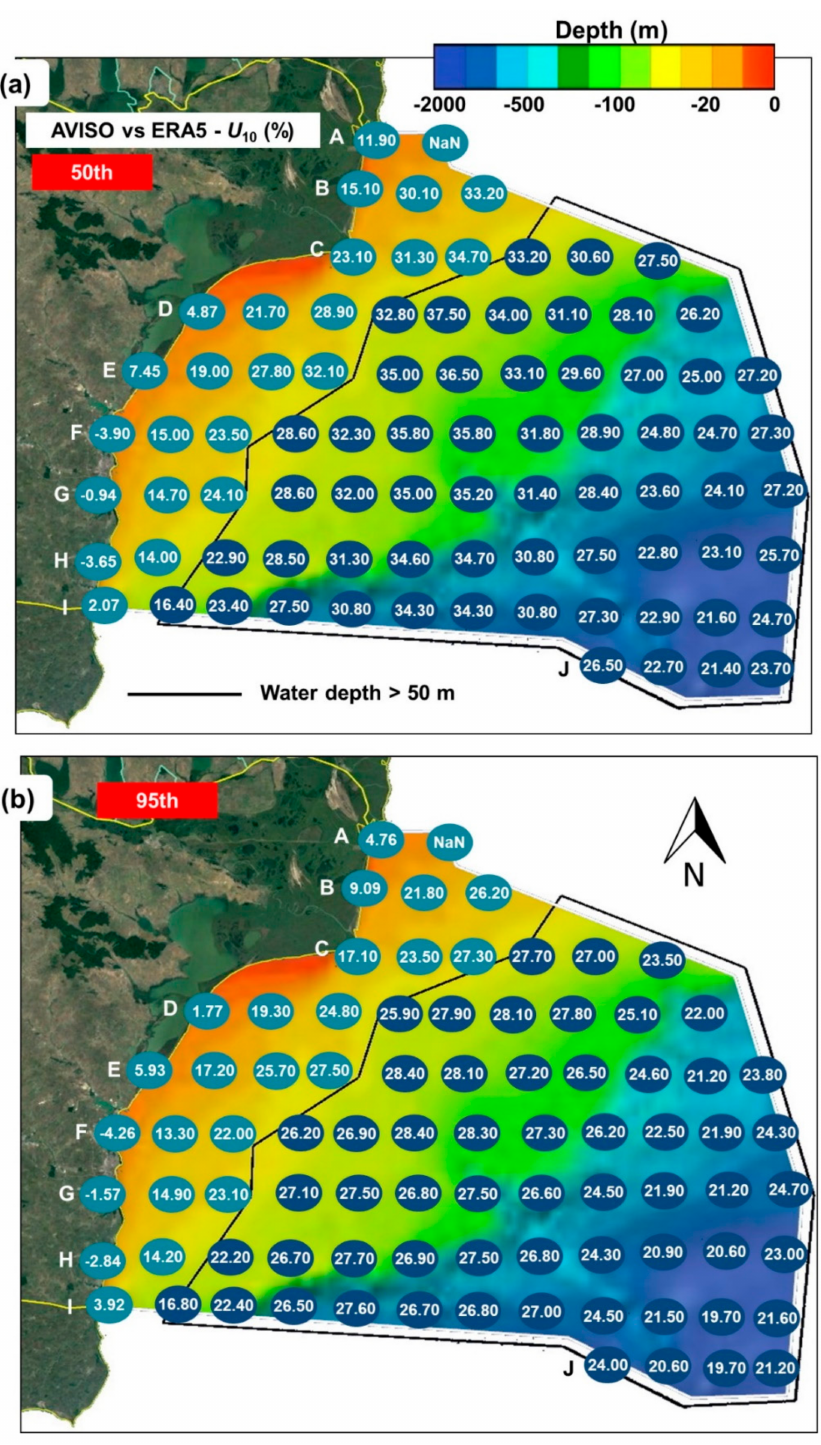
Figure 4. Comparisons between the AVISO ( U 10 ) measurements and the ERA5 ( U 10 ) reanalysis data for the 7-year time interval 2013–2019. The results are indicated in terms of: ( a ) 50th percentiles; ( b ) and 95th percentiles. A positive value indicates that the ERA5 wind speed is higher than that provided by the AVISO